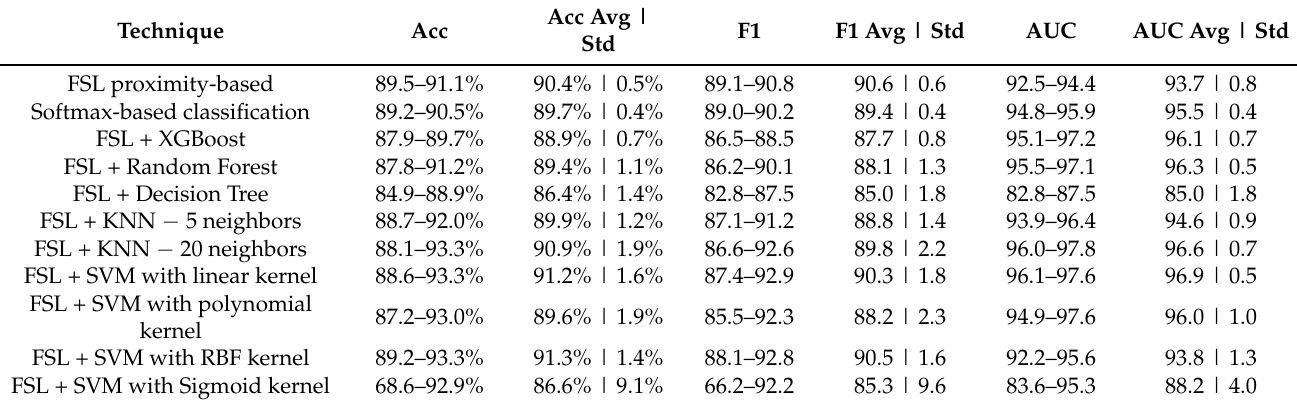
Table 2. Results for two-class classification, part